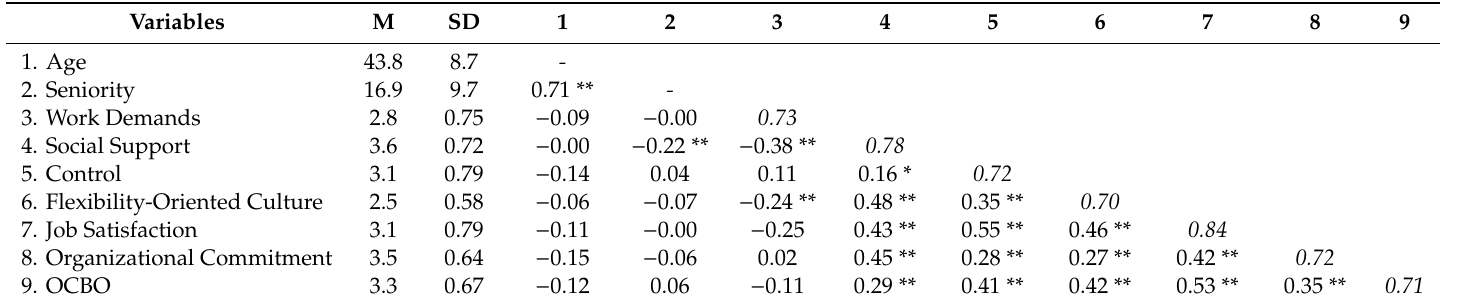
Table 2. Means, standard deviation, correlations ( N = 182), and discriminant